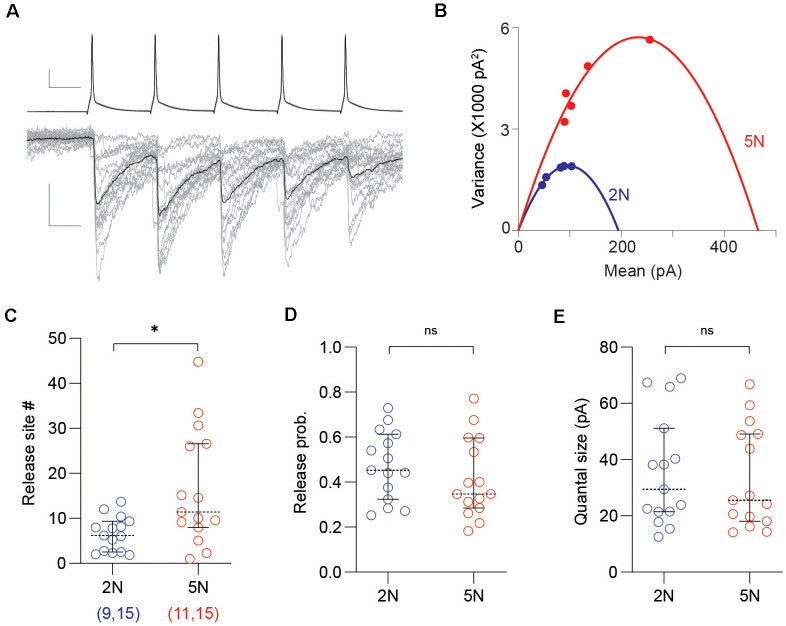
Mean-variance analysis reveals a developmental increase of release sites per PV-IN→Pyr connection. (A) Representative uIPSC evoked by 50 Hz trains (of five pulses) used in the mean-variance analysis to estimate synaptic parameters. Superimposed traces are 15 consecutive sweeps (gray) and the averaged response (black). Scale bars represent 20 mV, 100 pA, and 10 ms. (B) The relationship between mean amplitude and variance of the five uIPSCs in the trains from 2N (blue) and 5N (red) mice were fitted with parabolas. (C–E) Summary graphs depicting synaptic parameters including the number of release sites (C), the release probability (D), and the quantal size (E) estimated from the parabolic fit (see “Materials and Methods” section) in 2N and 5N mice. Circles represent individual cases, horizontal bars indicate the median with 95% CI. The number of mice and analyzed cell pairs are indicated in parentheses. Asterisks indicate p < 0.05. ns: not significant.